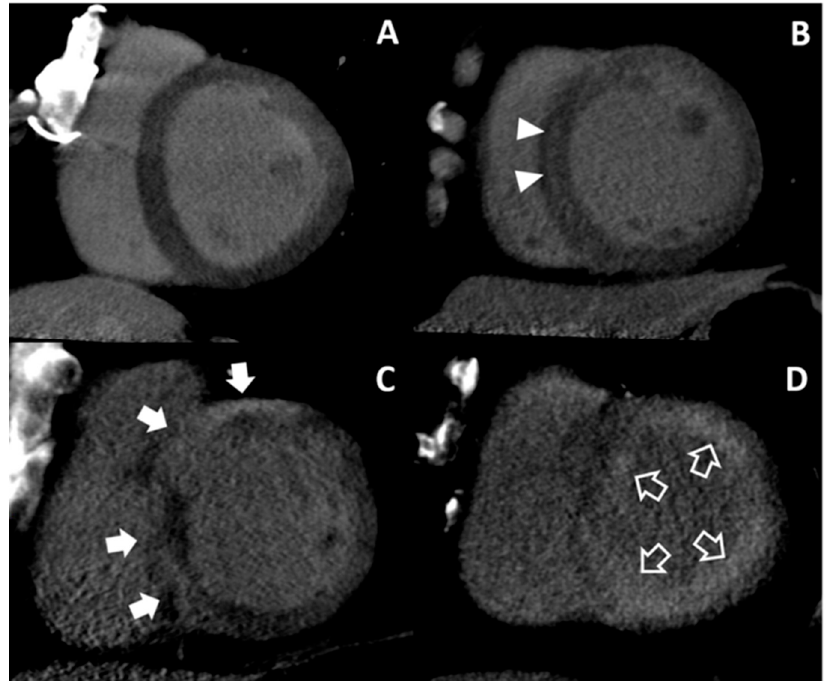
Figure 3. Representative cases of nonischemic heart failure. No MDE is noted on the LV (Group I) ( A ). Ill-defined midwall MDE (arrow heads) is presented in the mid LV septum (Group III) ( B ). Multifocal epicardial MDEs (arrows) are noted in the basal septum (Group IV) ( C ). Global subendocardial MDE (open arrows) is demonstrated along the LV (Group V) ( D ). LV = left ventricle, MDE = myocardial delayed enhancement.